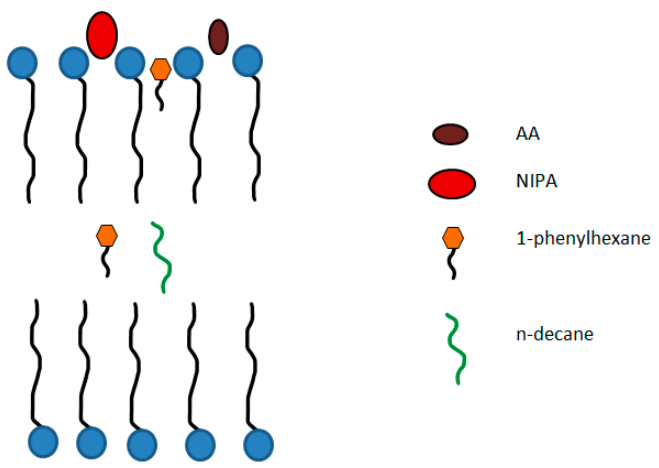
Figure 7. Schematic representation of the location of different additives inside the surfactant ag- gregates.